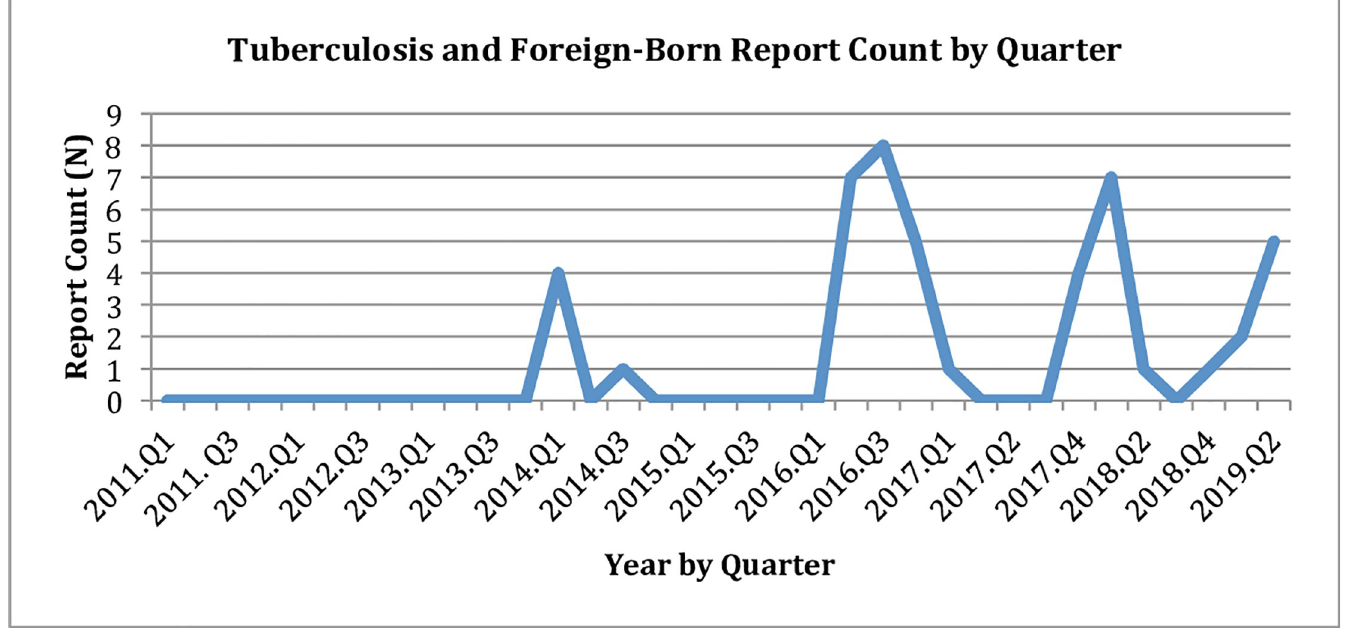
Fig 2. Tuberculosis and foreign-born persons report count by quarter.